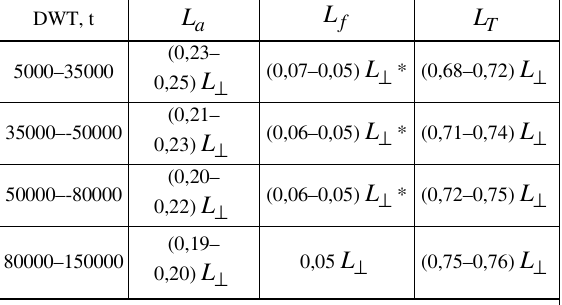
tom bulkhead of cargo compartments,